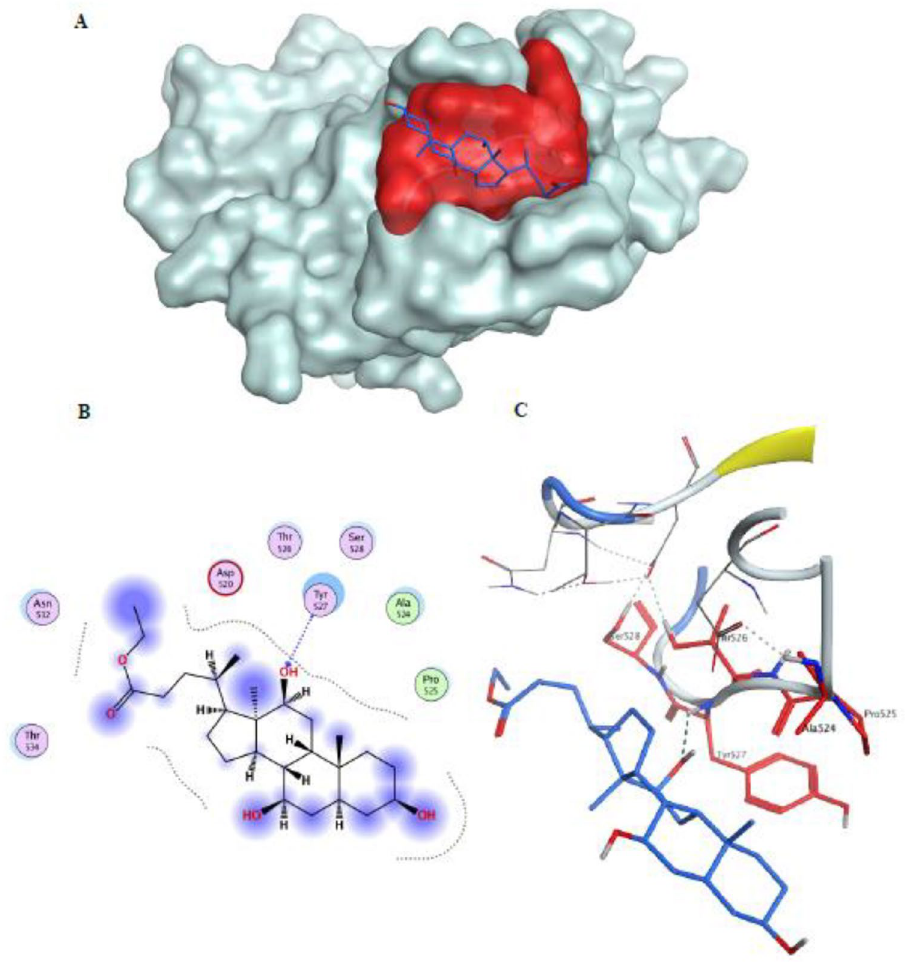
Figure 7. ( A ) Docking ethyl iso-allocholate (blue sticks) to epitope III (red molecular surface) on HCV E2 (white molecular surface), ( B ) 2D interactions, and ( C ) 3D binding mode of ethyl iso-allocholate (blue